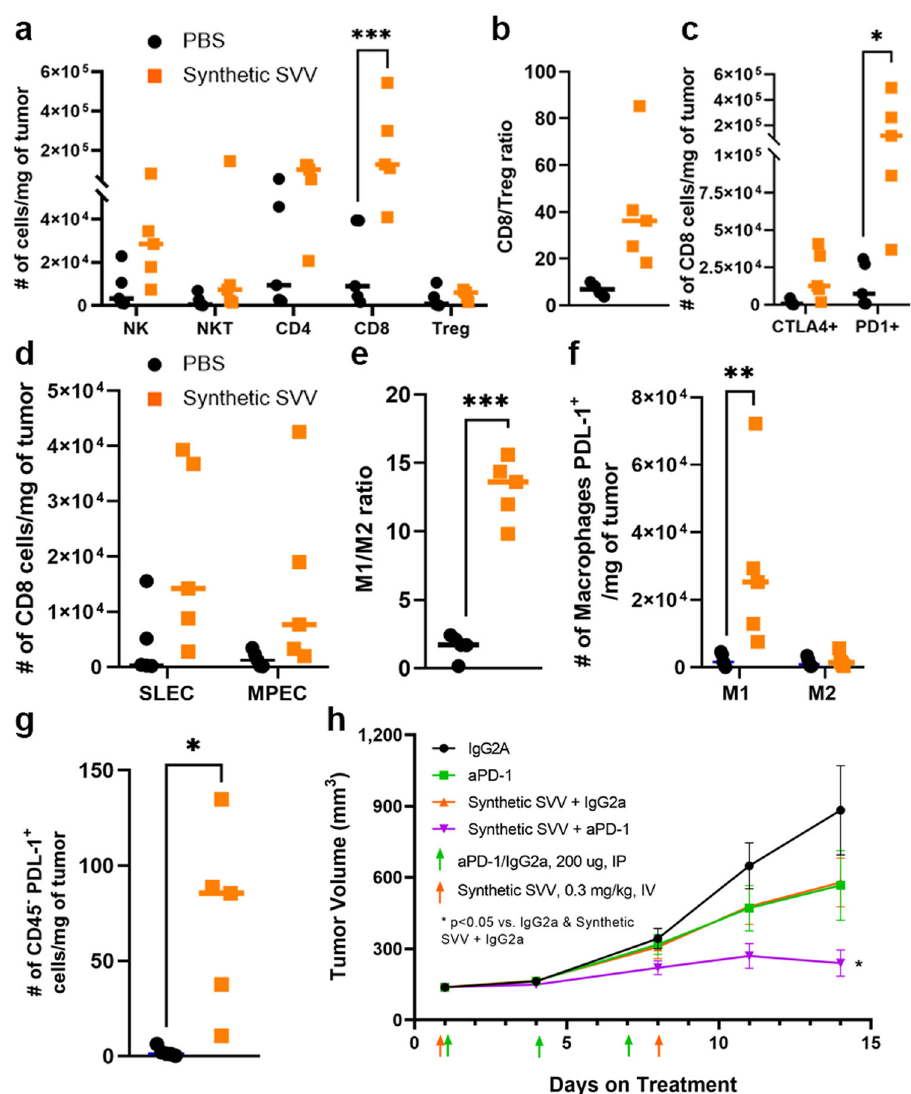
Fig. 5 | Synthetic-SVV promotes immune cell recruitment and enhances the activity of PD-1 inhibitor. a – g A/J mice ( n =5 per group) implanted sub- cutaneously with syngeneic neuroendocrine N1E-115 tumors. Mice were treated by IVadministrationwitheitherPBSvehicle controlor1mg/kgSynthetic-SVVonDays 1and8.Tumorswerecollected6daysaftertheseconddose. a NumberofNK,NKT, CD4, CD8, and Treg cells per mg of tumor. For CD8 p =0.0002 with a two-way ANOVA test b CD8/Treg ratio. c Number of CD8 T cells per mg of tumor that express CTLA-4 or PD-1. For PD1 p =0.01 with a two-way ANOVA test. d Number of CD8 T cells per mg of tumor that are SLEC (CD127-KLRG1+) or MPEC (CD127+- KLRG1 − ). e Ratio of M1/M2 macrophages. p =0.0002 with a two-tailed paired